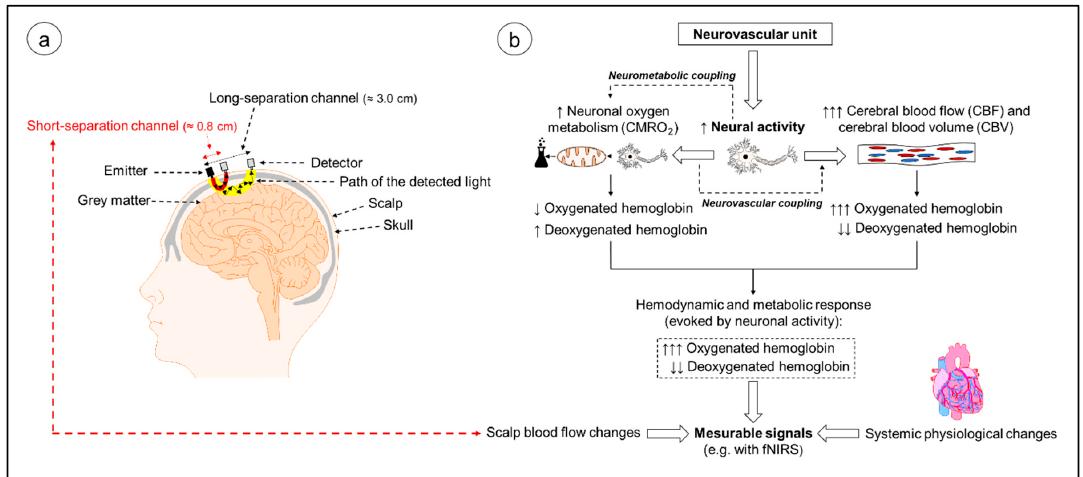
Figure 1. ( a ) Schematic illustration of the neurovascular unit and the changes in cerebral hemodynamics and oxygenation induced by neural activity. ( b ) Exemplary illustration of a possible NIRS montage on the human head and the assumed banana-shaped course of detected light of “short-separation channels” and of “long-separation channels”. fNIRS, functional near-infrared spectroscopy; CMRO 2 , cerebral metabolic rate of oxygen; ↑ , increase; ↓ , decrease.